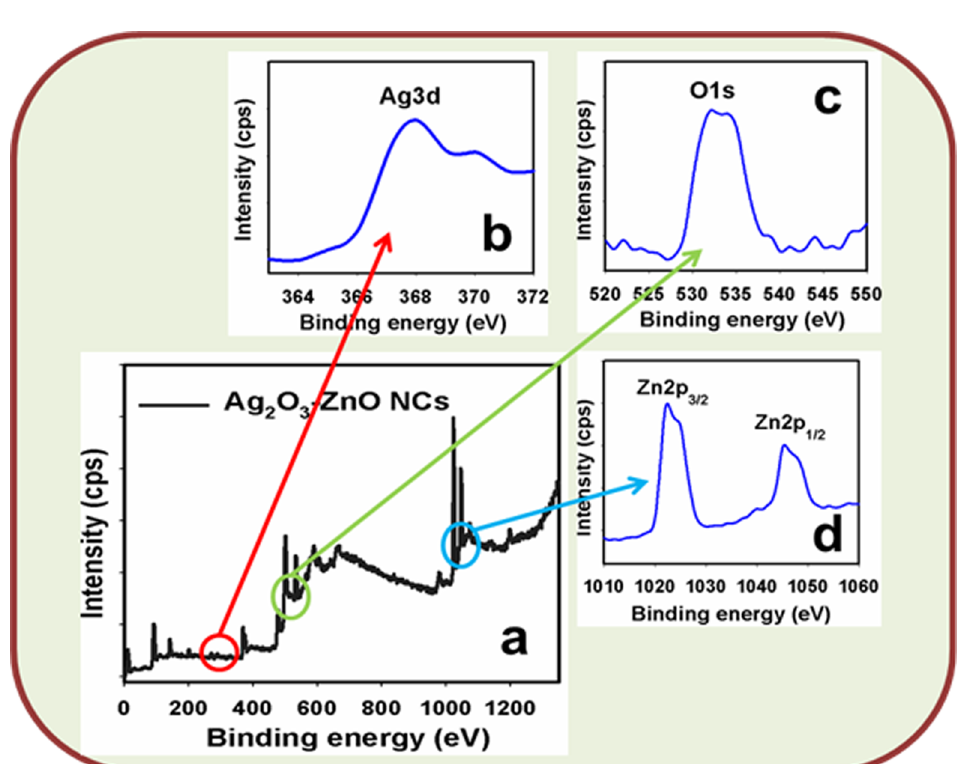
Figure 5. Studied of Binding energy. XPS of (a) doped Ag 2 O 3 -ZnO NCs, (b) Ag3d level, (c) O1s level, and (d) Zn2p level acquired with MgK a